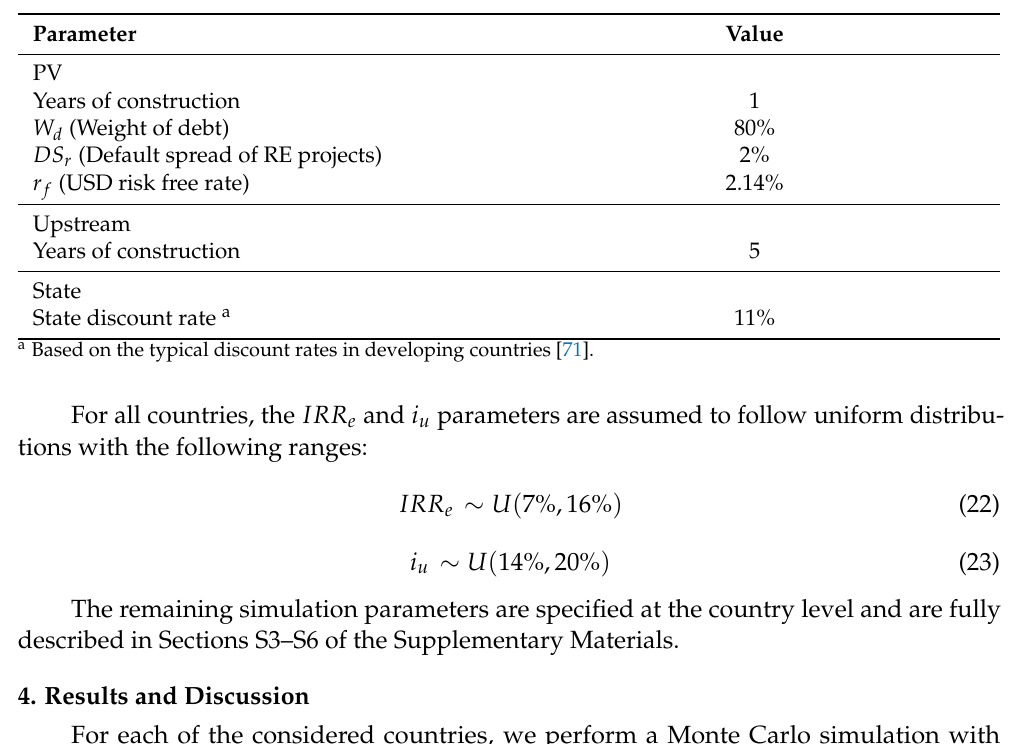
Table 3. Parameters kept constant for all